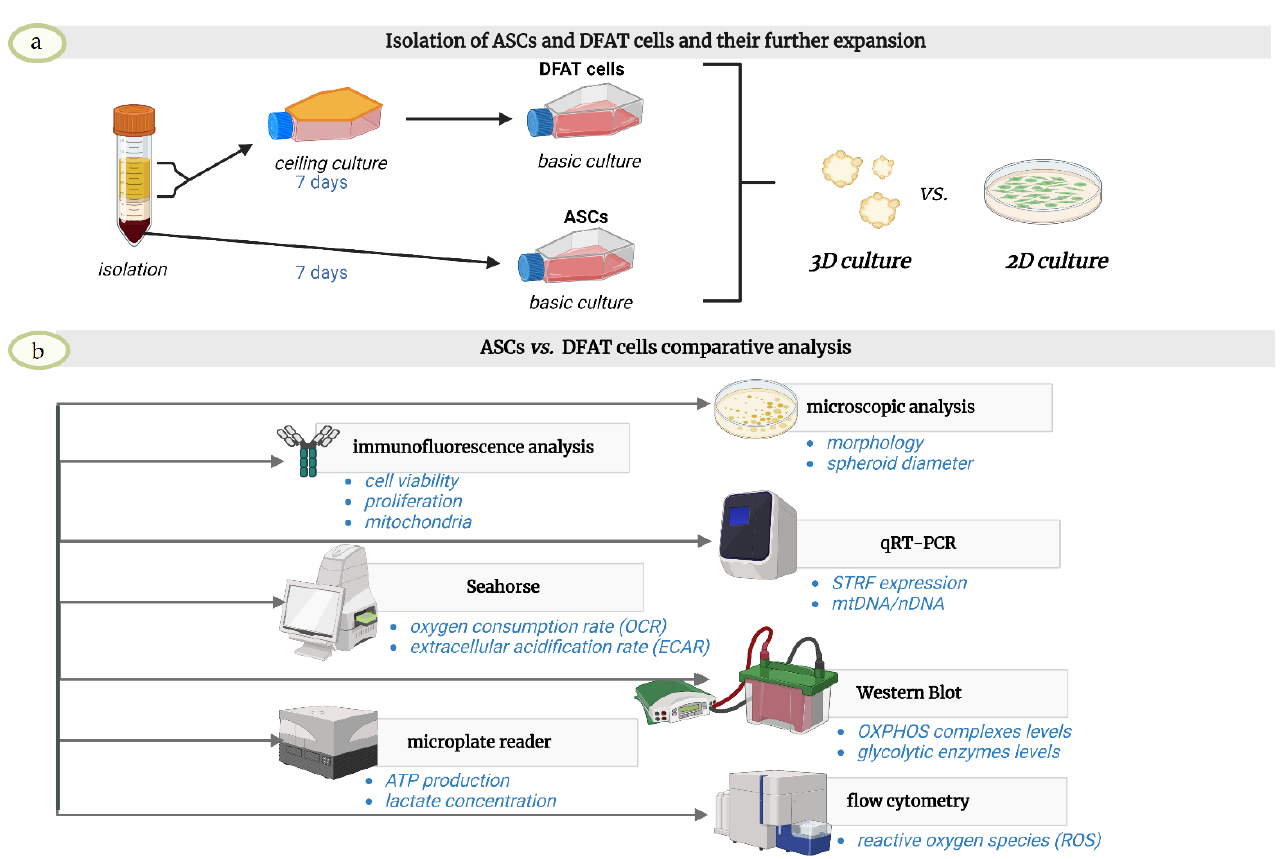
Figure 1. Overview of experimental steps. ( a ) Isolation of ASCs and DFAT cells and their further expansion ( b ) ASCs and DFAT cells comparative analysis. expansion ( b ) ASCs and DFAT cells comparative